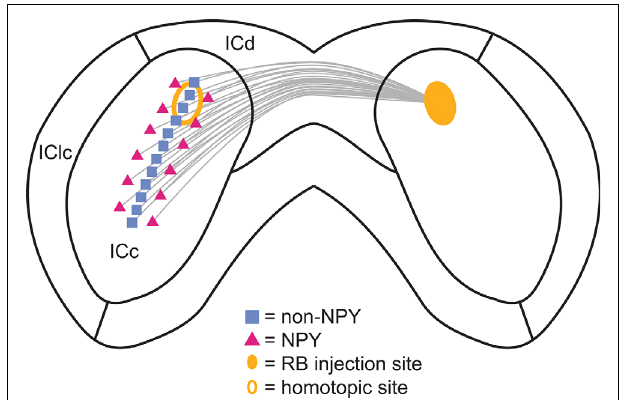
FIGURE 9 | Summary of the commissural projection patterns of NPY and non-NPY neurons between the left and right ICc. The commissural projections of non-NPY neurons tended to be homotopic and to connect regions that likely represent similarly tuned frequency laminae in the left and right ICc. In contrast, the commissural projections of NPY neurons were more heterotopic and more likely to arise from regions bordering the region where non-NPY commissural neurons were found. These patterns suggest that non-NPY neurons connect regions of the left and right ICc that have similar functional roles and similar frequency tuning, while NPY neurons connect regions with dissimilar functional roles and often different frequency tuning. Thus, NPY neurons likely represent an important source of lateral and/or sideband inhibition to the contralateral